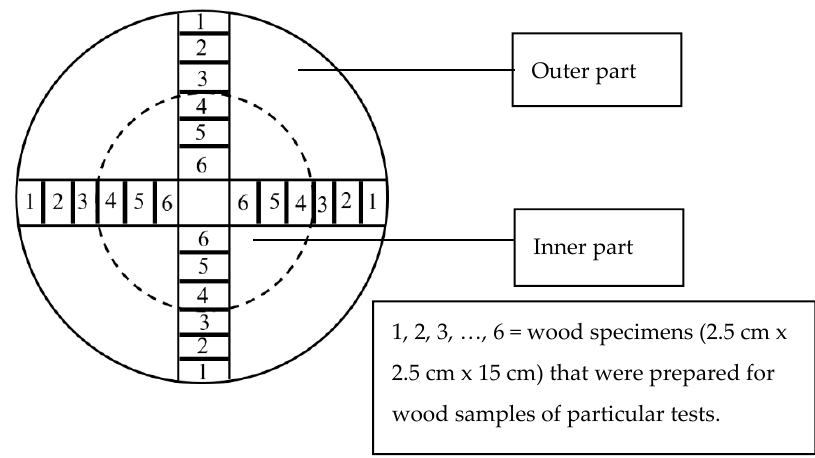
Figure 2. Cutting pattern of each gewang discs to prepare wood sample, representing outer part and inner part of gewang trunk.